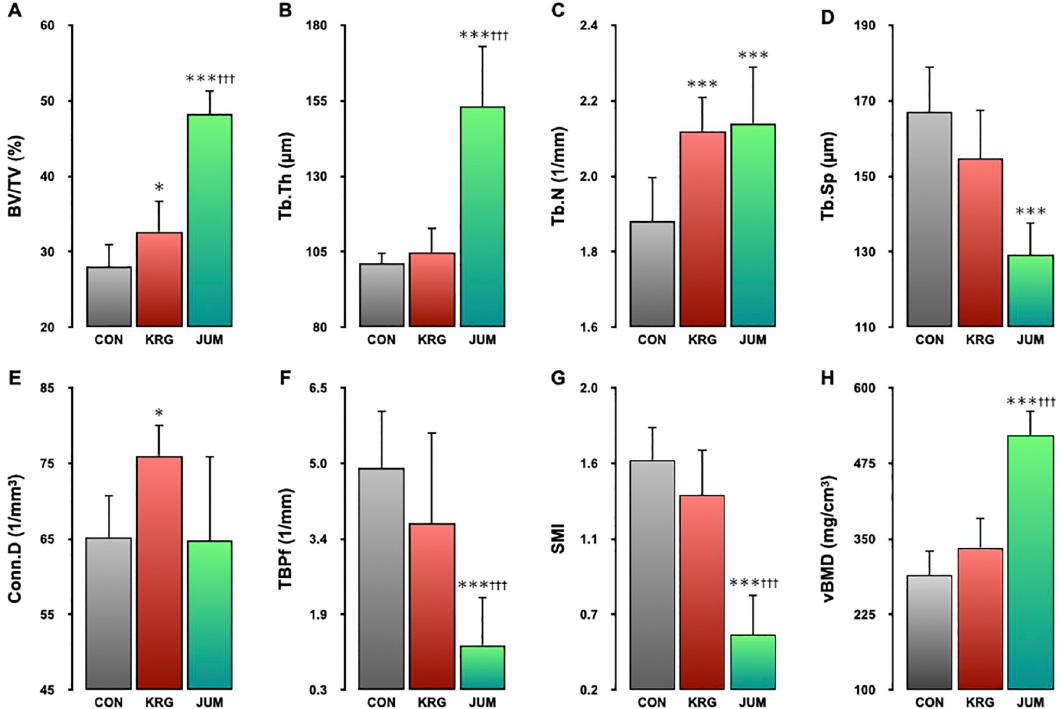
Fig 2. Microstructural parameters in the distal femoral metaphysis as measured by micro-CT. Trabecular microarchitecture parameters of the distal femoral metaphysis are shown as: BV/TV, trabecular bone volume fraction (A); Tb.Th, trabecular thickness (B); Tb.N, trabecular number (C); Tb.Sp, trabecular separation (D); Conn.D, connectivity density (E); TBPf, trabecular bone pattern factor (F); SMI, structure model index (G); vBMD, volumetric bone mineral density (H). Male Wistar rats that were 11 weeks old at the beginning of the study were distributed into 3 groups: a group administered 200 mg/kg body weight of Korean red ginseng daily (KRG); a group that jumped 10 times/day from a height of 40 cm (JUM); and control group without exercise or KRG administration (CON). All data represent mean ± SD. Significant difference vs. CON group: � p < 0.05; �� p < 0.01; ��� p < 0.001. Significant difference vs. KRG group: †† p < 0.01; ††† p <